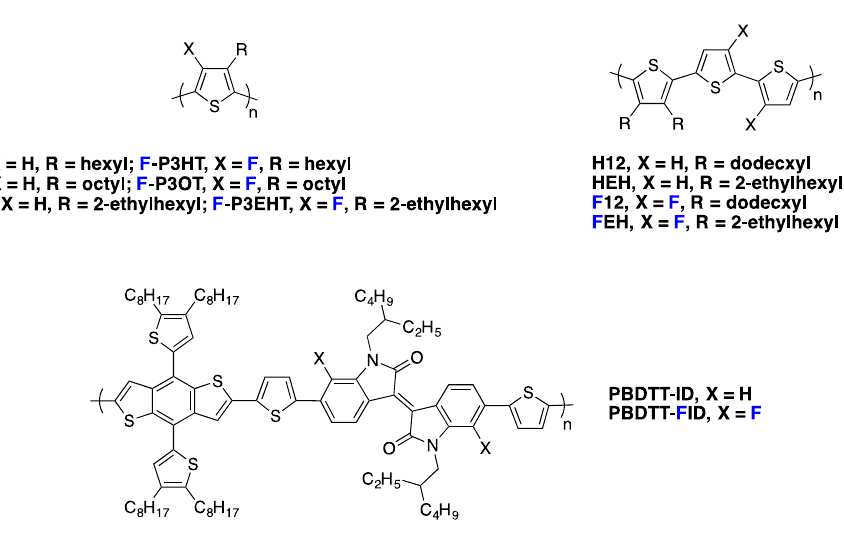
Figure 13. Chemical structures of some fluorinated polymers.